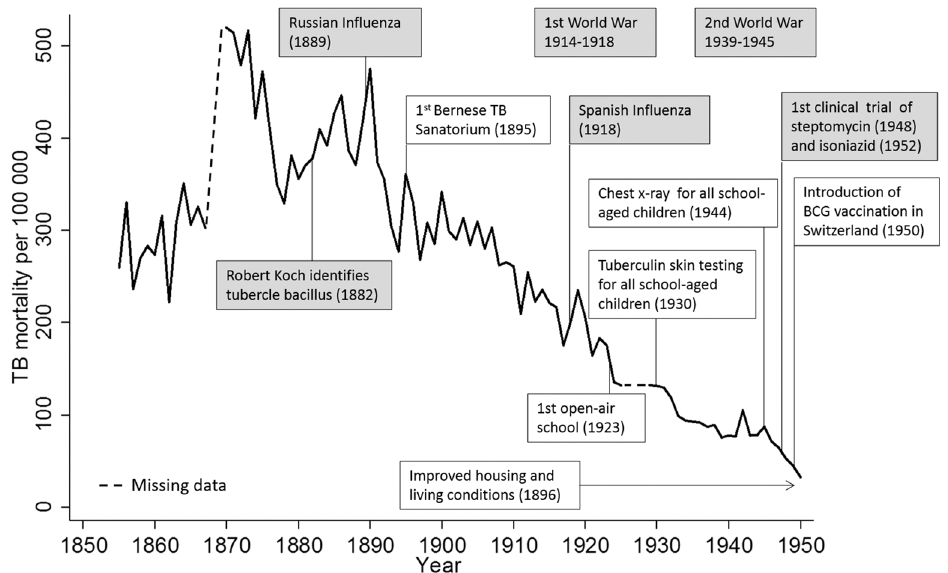
Fig 4. Trends in TB mortality in the city of Bern, Switzerland, between1856 to 1950, in relation to important events for TB control. Boxes in grey show worldwide